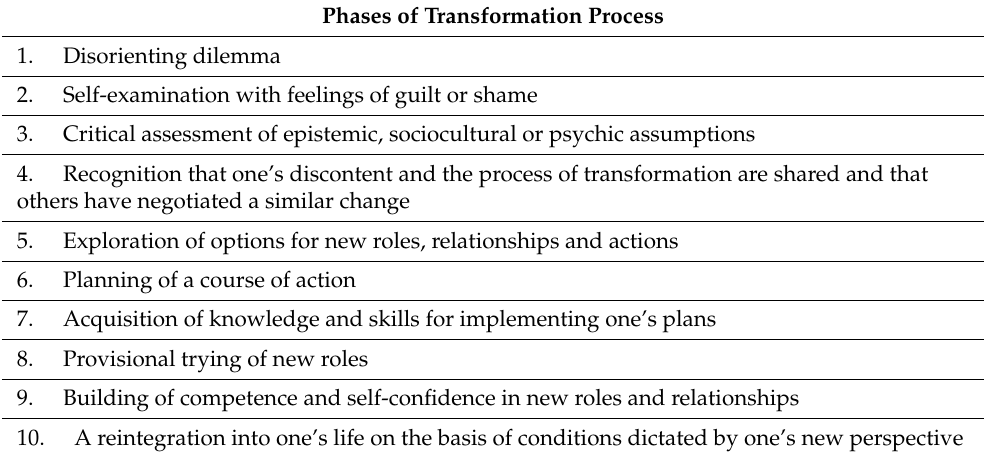
Table 1. Mezirow’s ten phases of transformation [47]